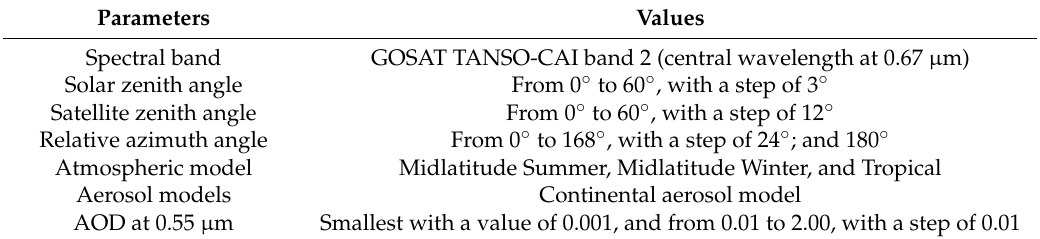
Table 2. The input parameters of the 6S radiation transfer code for a pre-computing look-up